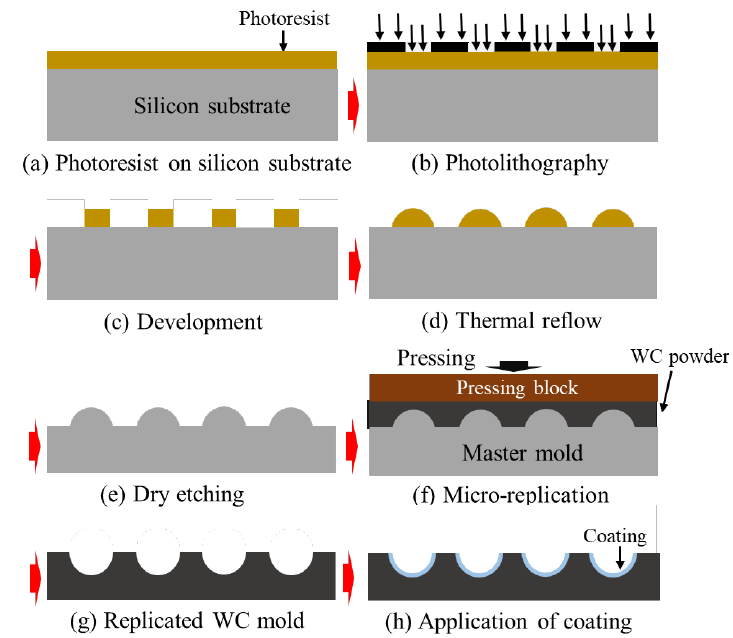
Figure 6. Schematic illustration of the fabrication of a WC mold using replication from a master mold: ( a ) photoresist layer on a Si substrate, ( b ) patterning photoresist layer, ( c ) development of the photoresist pattern, ( d ) thermal reflow, ( e ) dry etching of Si, ( f ) sintering of WC powder via replication, ( g ) replicated WC mold, and ( h ) anti-adhesion coating on the WC mold.